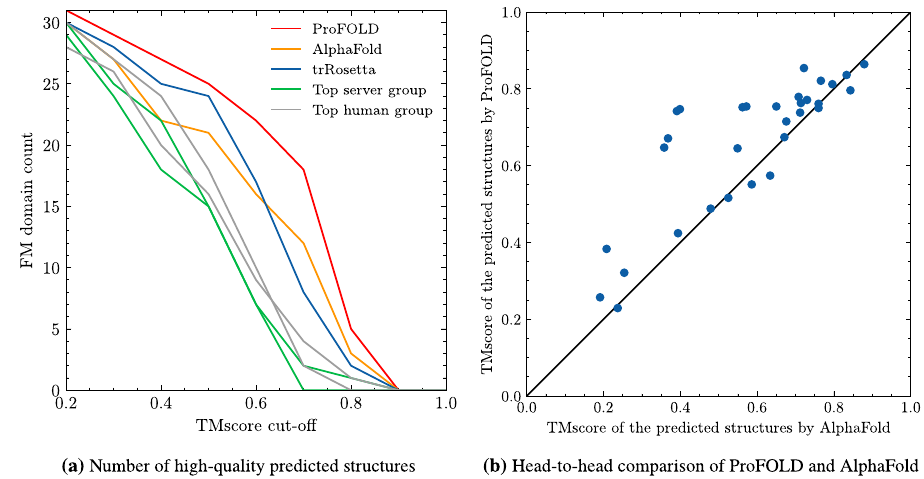
Fig. 5 Quality of the predicted tertiary structures for CASP13 FM target proteins. a ProFOLD predicted more high-quality structures than the state-of- the-art approaches. When using the popular cut-off threshold for high-quality structures (TMscore ≥ 0.70), ProFOLD predicted high-quality structures for 18 out of the 31 domains, whereas AlphaFold and trRosetta predicted high-quality structure for only 12 and 7 domains, respectively. b Head-to-head comparison clearly demonstrates the advantages of ProFOLD over AlphaFold: for 24 out of the 31 FM domains, ProFOLD outperformed AlphaFold.